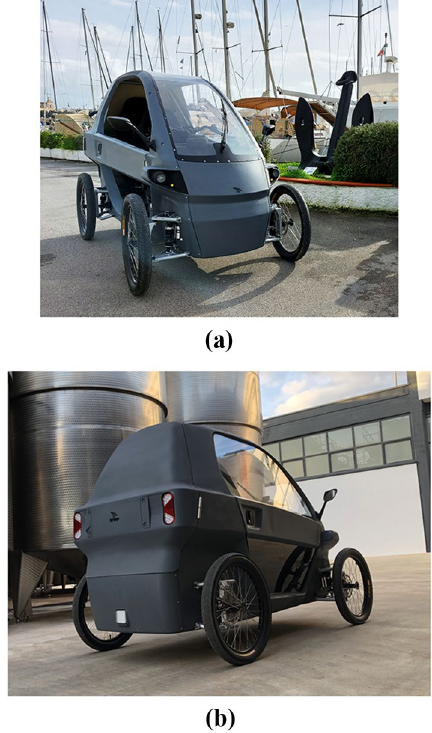
Fig. 5 Some views of SNAP: a front, b rear